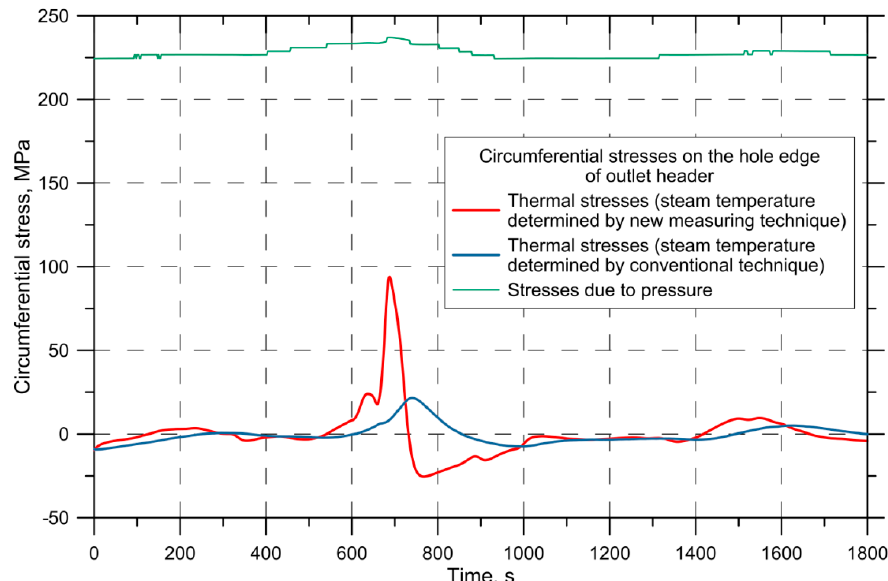
Figure 21. Circumferential thermal and due to pressure stresses on the hole edge of the outlet header computed using the steam temperature obtained by the proposed measuring technique and conventional industrial thermometer.